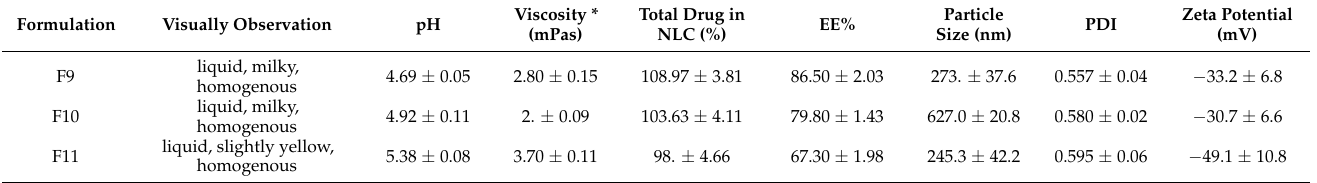
Table 3. Characteristics of ETD-NLC formulations (mean ± SD; n =